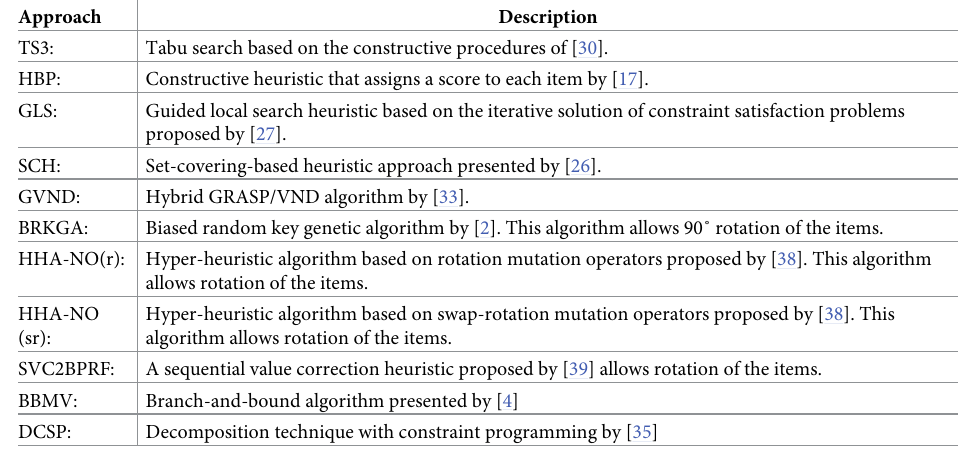
Table 9. Comparative approaches for the